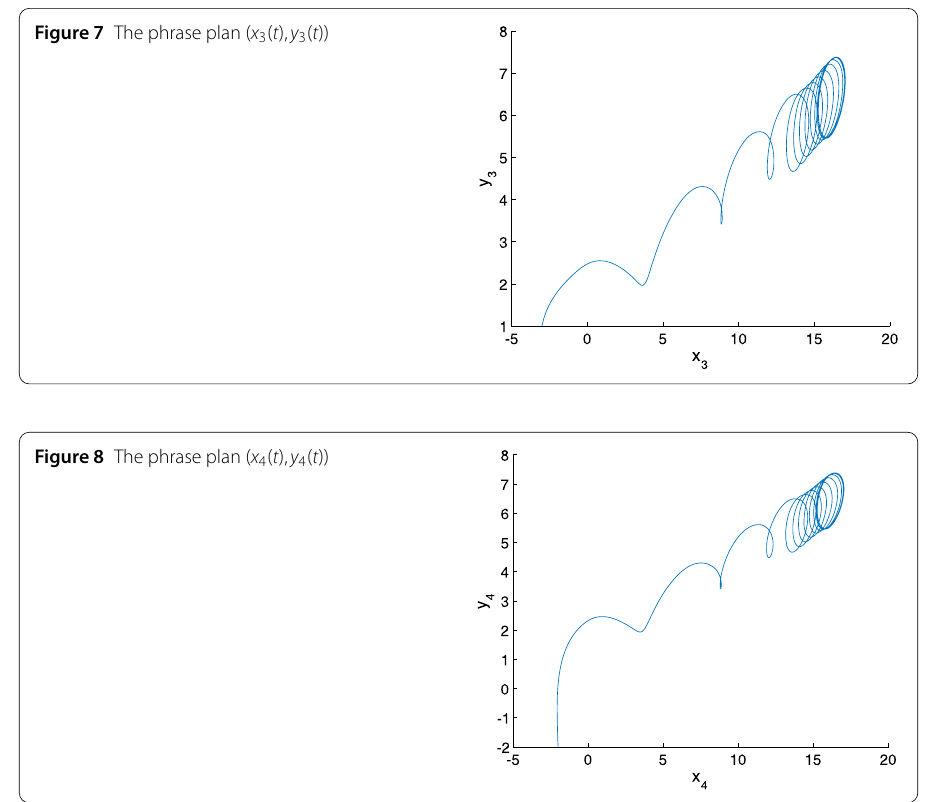
Figure 7 The phrase plan ( x 3 ( t ), y 3 ( t ))